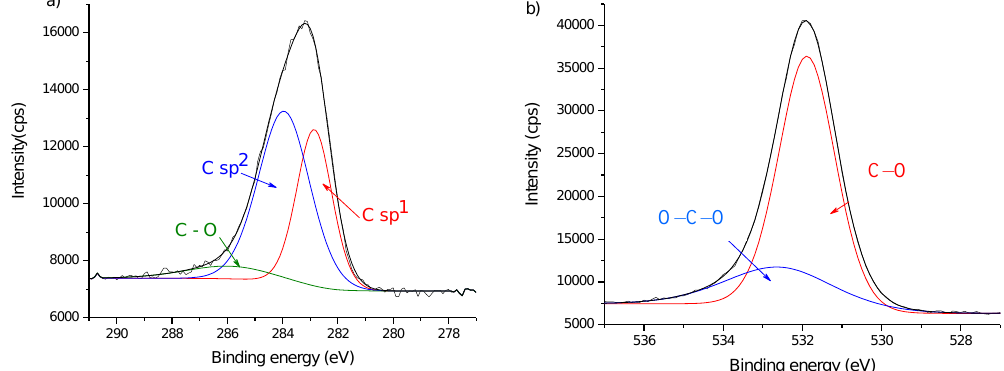
Figure 3. Deconvolution of the high resolution spectra of surface Cu-C15: ( a ) C1s, indicating only the presence of carbyne (sp 1 ) and graphene-like (sp 2 ) hybridized bonds, as well as the presence of C–O bonds; ( b ) O1s, showing that oxygen is manly bounded to carbon.